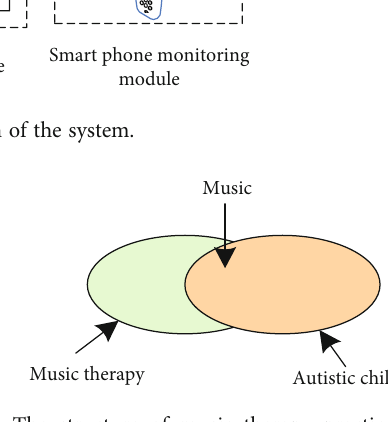
Figure 2: The structure of music therapy practice for children with autism.